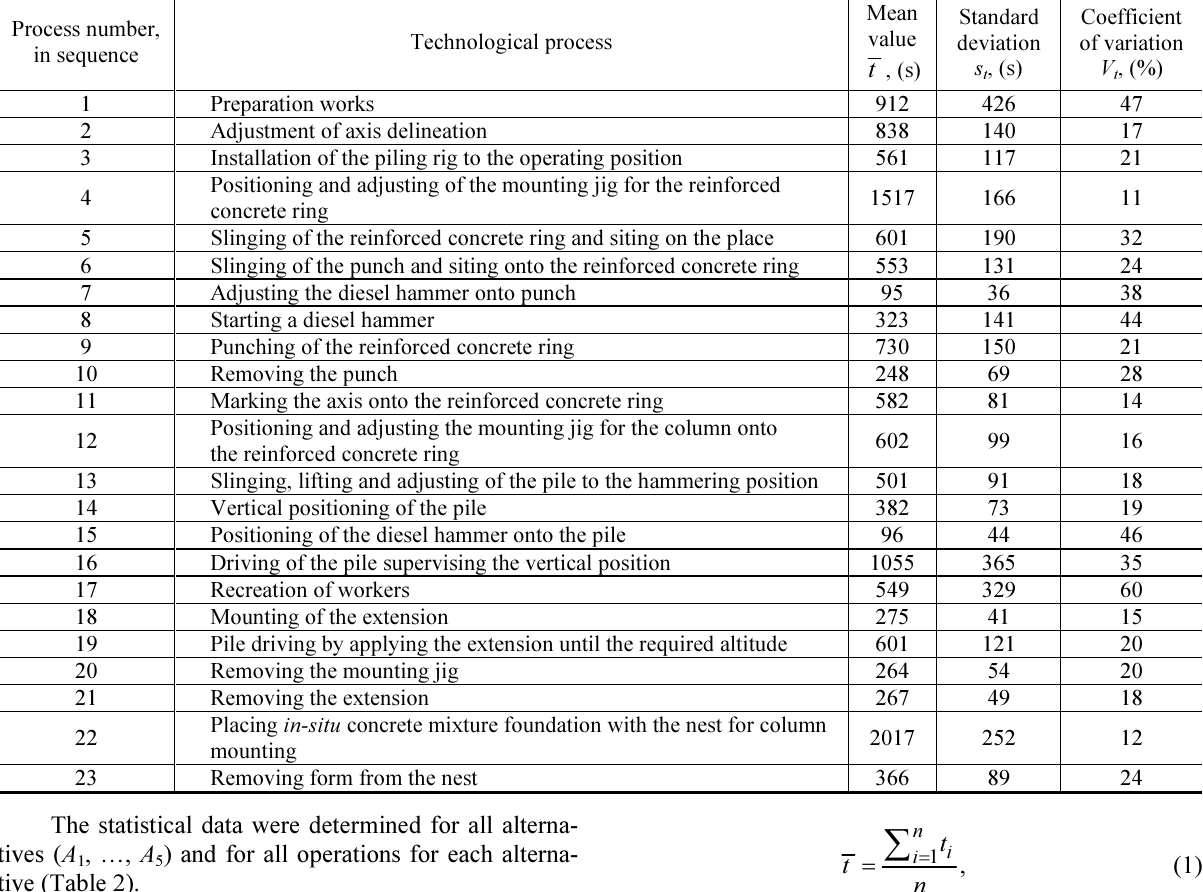
1 ), for warehouse